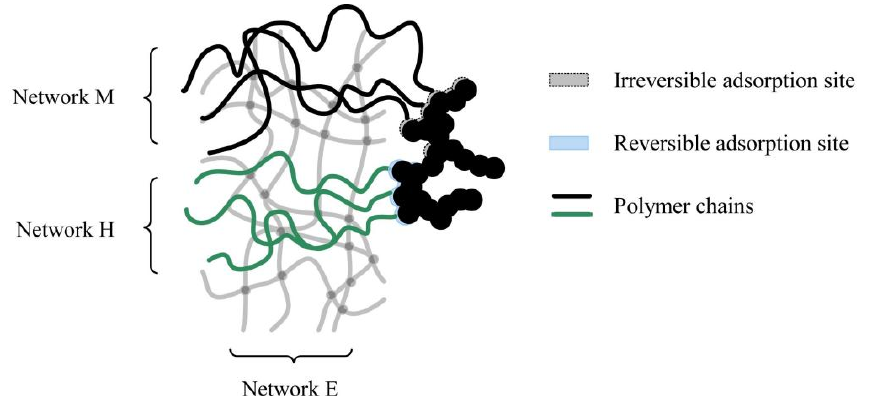
Figure 11. Two adsorption sites on the filler surface [18].